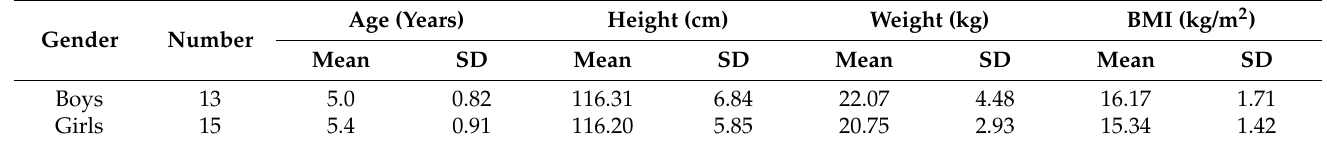
Table 1. Details of Participants in the Experiment.